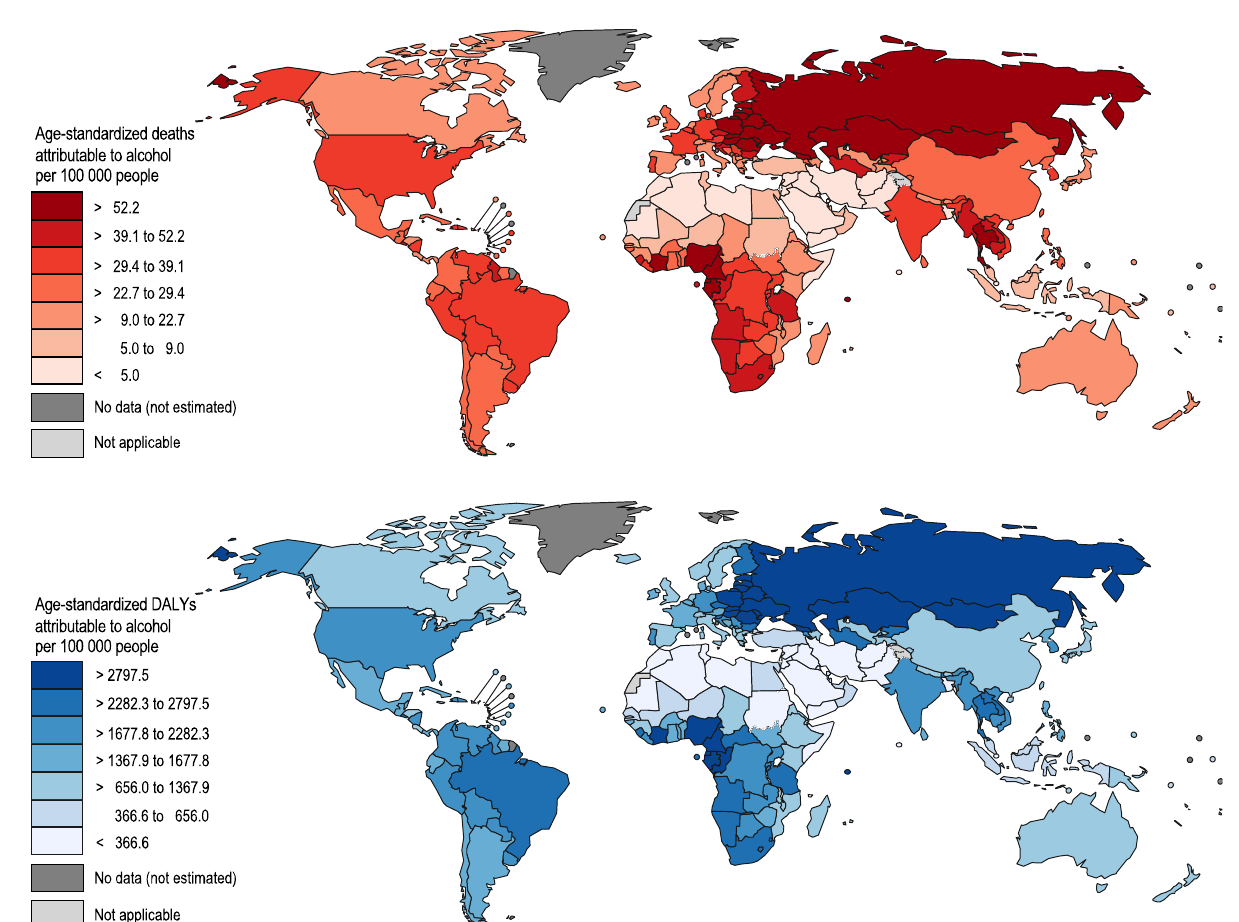
Figure 2. Alcohol-attributable deaths and disability adjusted years of life lost globally in 2016 among people 0 to 69 years of age.